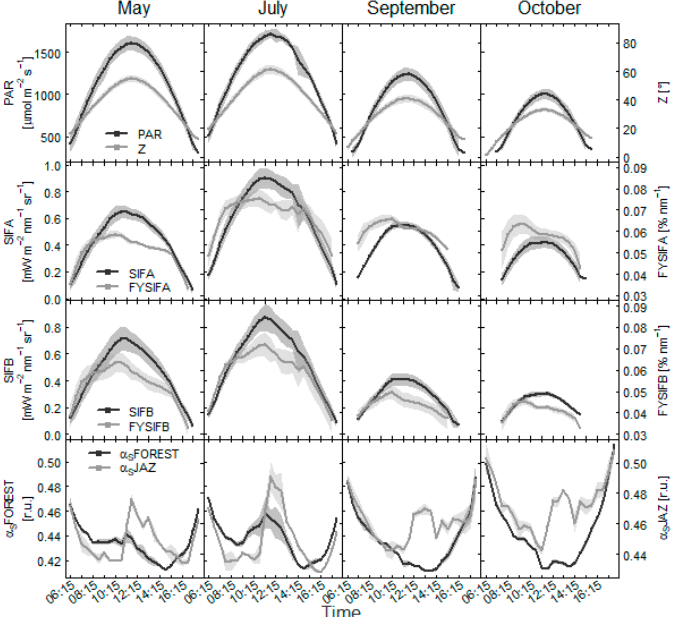
Figure 7. Diurnal change of incoming PAR to the forest at the Bílý K ř íž site on days evaluated as clear days. Daily dynamics of fluorescence emission in O 2 A band and O 2 B bands from the spruce forest are shown with adjacent change in the yield of this emission. The yield of SIFA and SIFB is expressed per unit of absorbed PAR (nm). Dynamics of shadow fraction in area under spectrometer ( α S JAZ) and at the forest level ( α S FOREST) at corresponding sun azimuth and zenith angles (Z) are shown in the bottom panel.